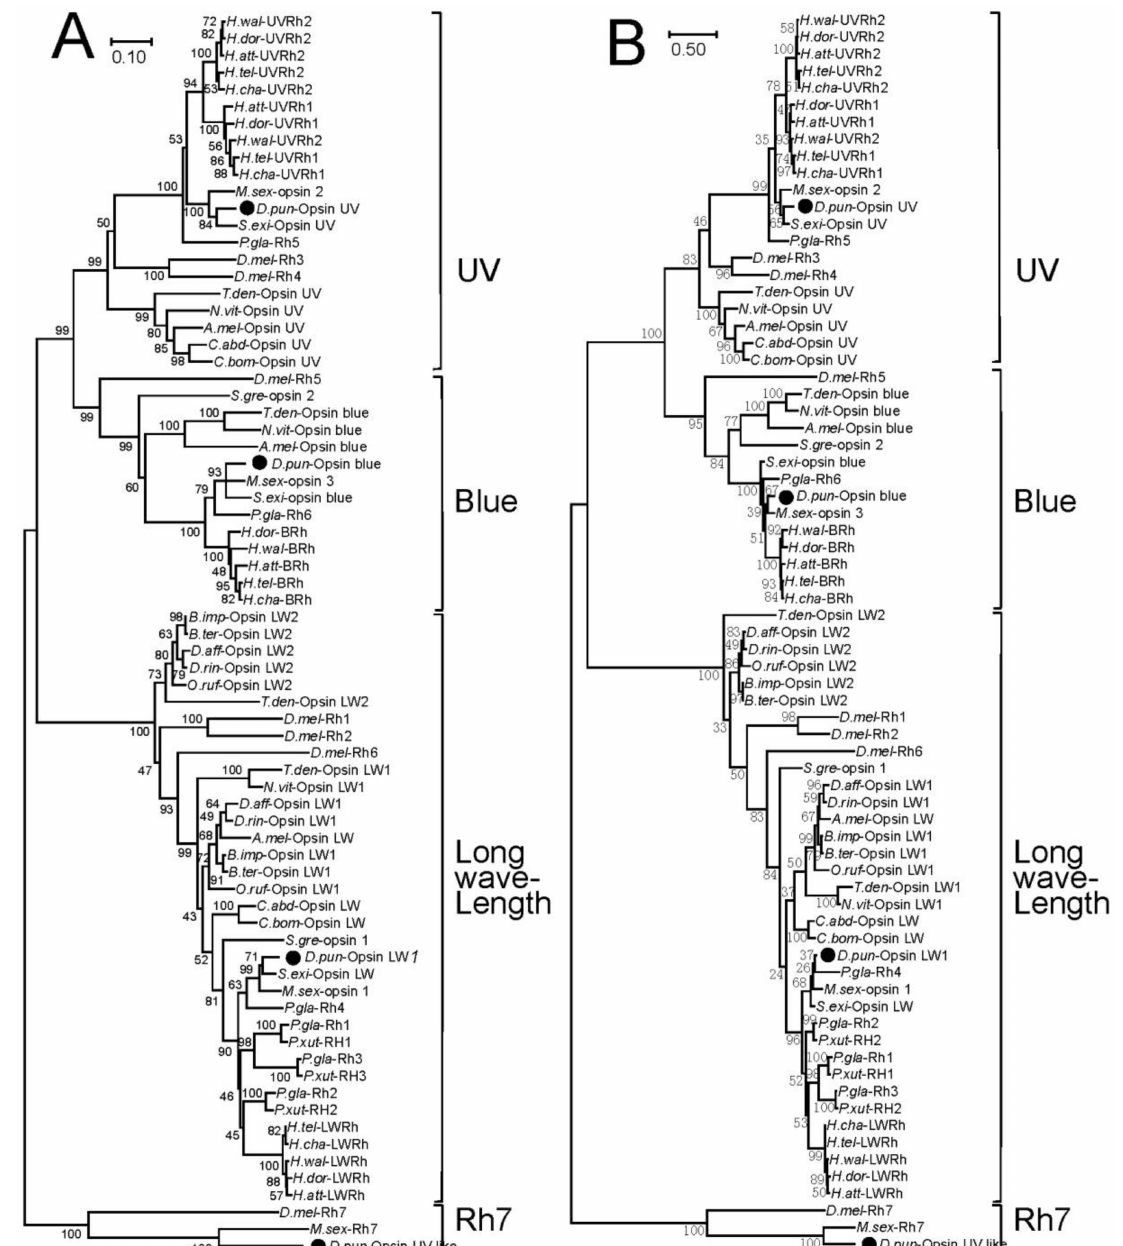
Figure 2. Neighbor-joining (NJ) and maximum likelihood (ML) trees based on protein sequences of opsin from Dendrolimus punctatus and other insects. Opsins from Dendrolimus punctatus ( D.pun ); Drosophila melanogaster ( D.mel ); Apis mellifera ( A.mel ); Trichogramma dendrolimi ( T.den ); Camponotus abdominalis ( C.abd ); Cataglyphis bombycinus ( C.bom ); Manduca sexta ( M.sex ); Papilio glaucus ( P.gla ); P. xuthus ( P.xut ); Schistocerca gregaria ( S.gre ); Bombus impatiens ( B.imp ), B. terrestris ( B.ter ); Diadasia a ffl icta ( D.a ff ); D. rinconis ( D.rin ); Osmia rufa ( O.ruf ); Heliconius wallacei ( H.wal ); Heliconius telesiphe ( H.tel ); Heliconius doris ( H.dor ); Heliconius charithonia ( H.cha ); Heliconius atthis ( H.att ); Spodoptera exigua ( S.exi ) ( A ) NJ tree constructed using MEGAX with 10000 bootstrap replications and Poisson model + uniform rates. ( B ) ML tree constructed by MEGAX with 500 bootstrap replications, and Le and Gascuel, 2008 model with frequencies and Gamma distributed sites (LG + F + G) model of evolution. The bar indicates phylogenetic distance, and the black points refer to the opsins of Dendrolimus punctatus